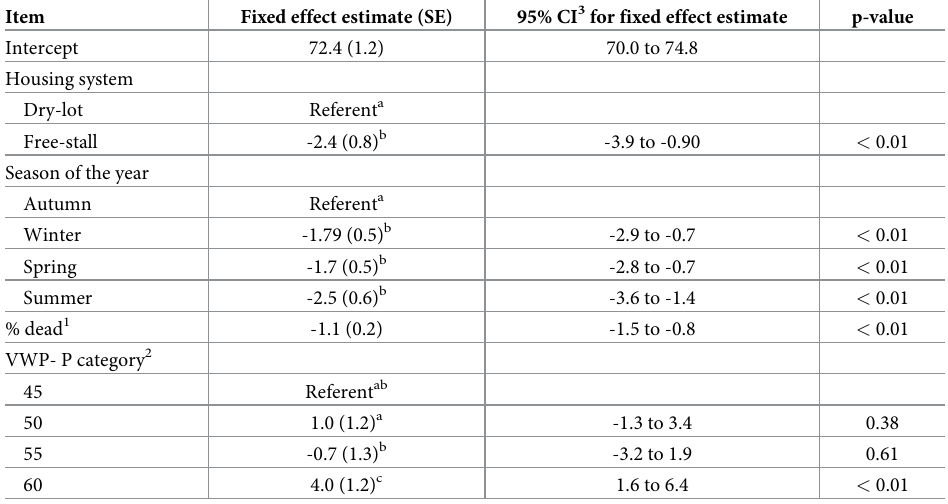
Table 3. Final multivariable linear regression model used to evaluate the association of various herd-level factors and insemination risk in large dairy herds located in